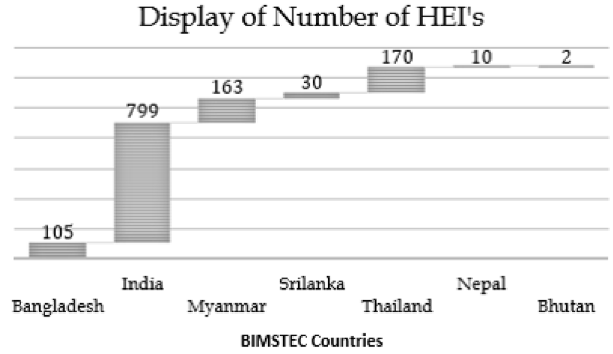
Figure 1. Number of higher education institutions in BIMSTEC countries as of